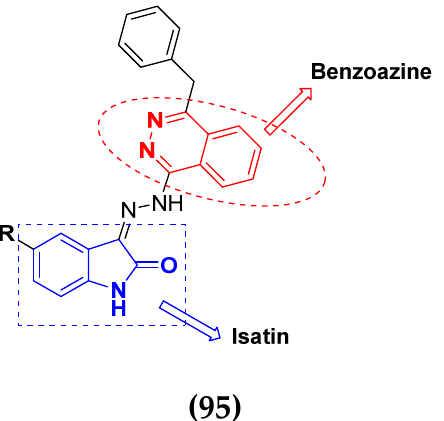
structure of isatin-based benzoazine derivatives is given in Figure 92 and in vitro cytotoxic activities of hybrid compounds 95 ( a – c ) are listed in Table 82 [171].